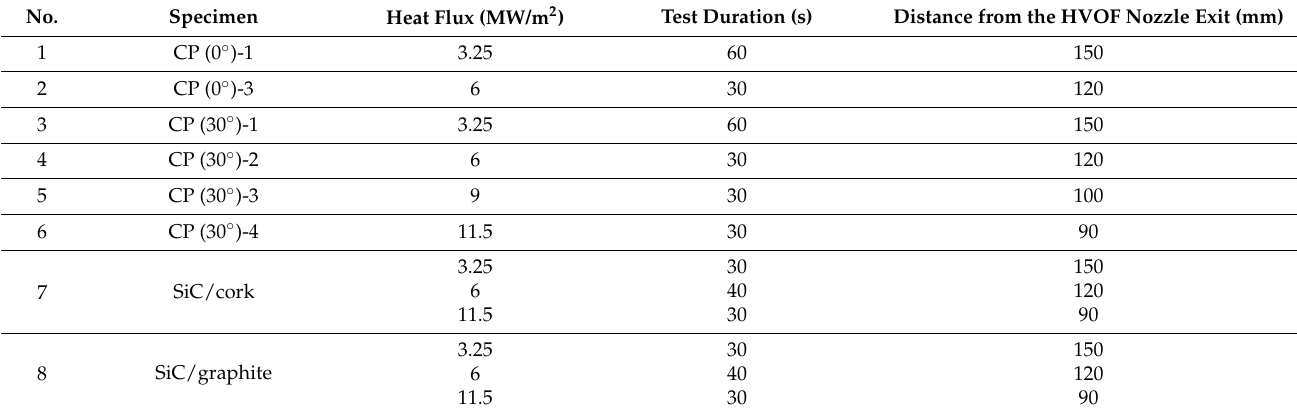
Table 1. Specimen test